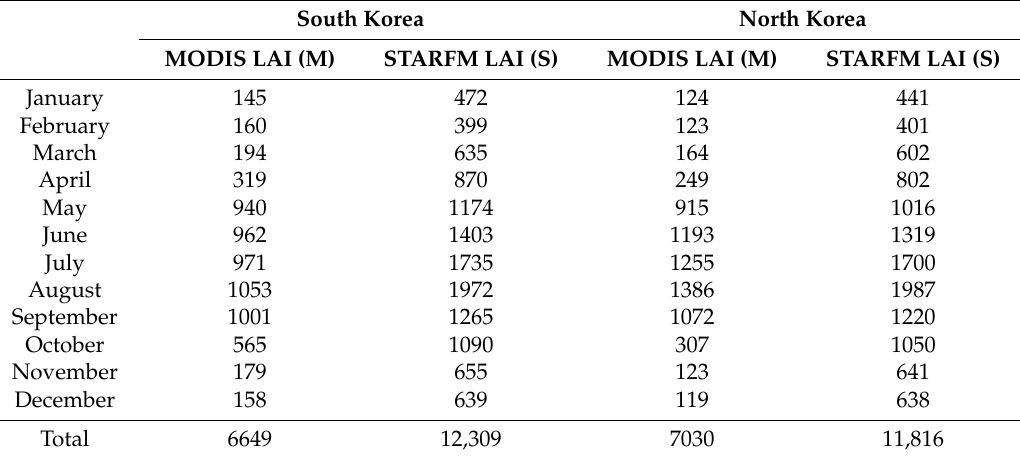
Table 5. Regional Leaf Area Index (LAI) monthly totals [dimensionless].